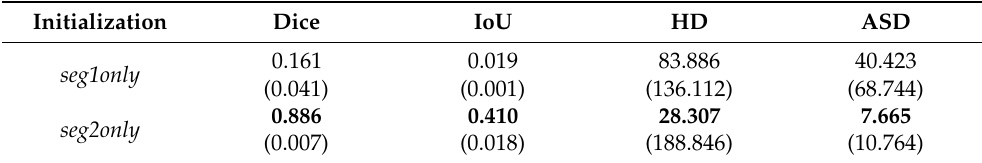
Table 7. The metric values for the Spleen dataset using only 100 labeled data points for training. The use of VGG16 in Generator 2 ( seg2only ) shows that it performs better than Generator 1 ( seg1only ) with a higher segmentation accuracy and is able to reduce the boundary error during